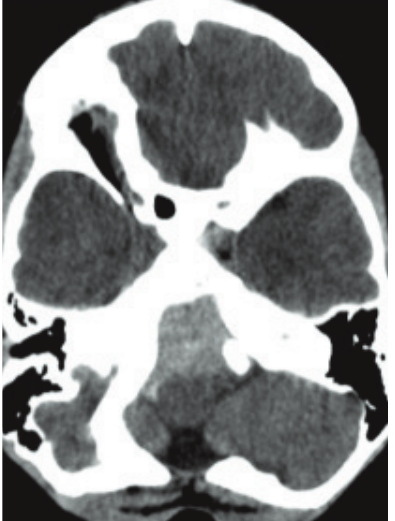
CCJ.Fig. 1. Axial CT scan at the level of the pons. Fig. 2. Axial CT scan at the level of the foramen